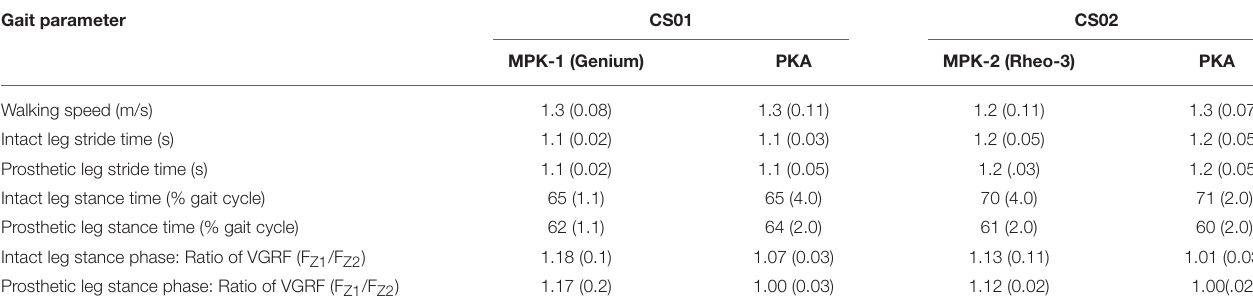
TABLE 1 | Temporal spatial parameters. Gait